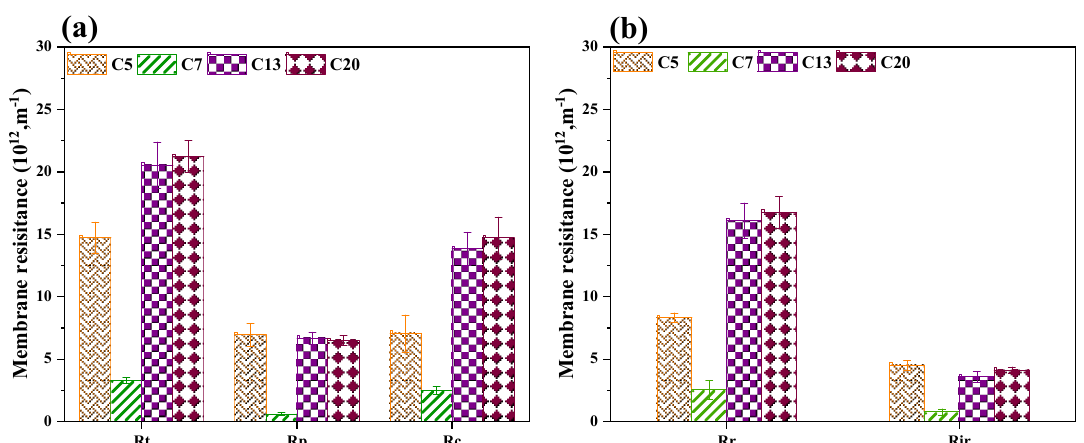
Figure 7. Distribution of membrane fouling resistances for different ceramic membranes in the CMBR: ( a ) pore blockage and cake layer resistances; ( b ) reversible and irreversible resistances.